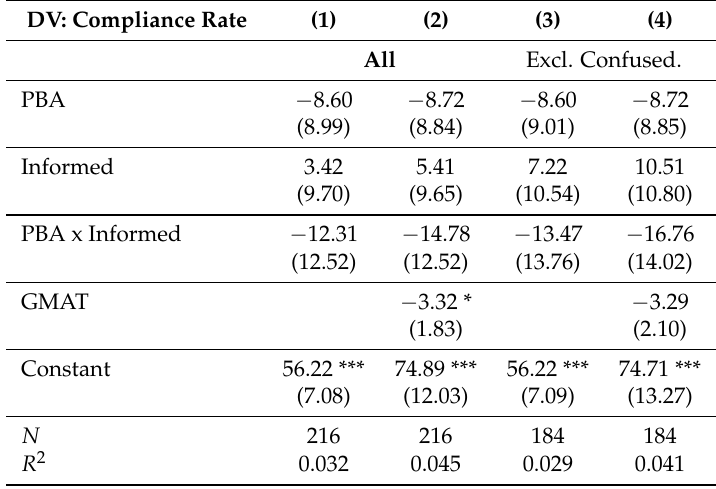
Table A10. Treatment interaction regressions